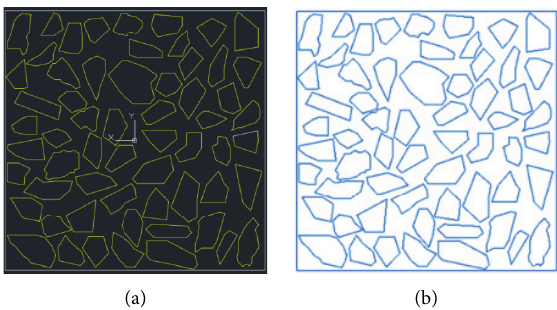
Figure 9: The vector diagram of the aggregate structure in CAD (a); the aggregate structure imported into the PFC 2D (b).